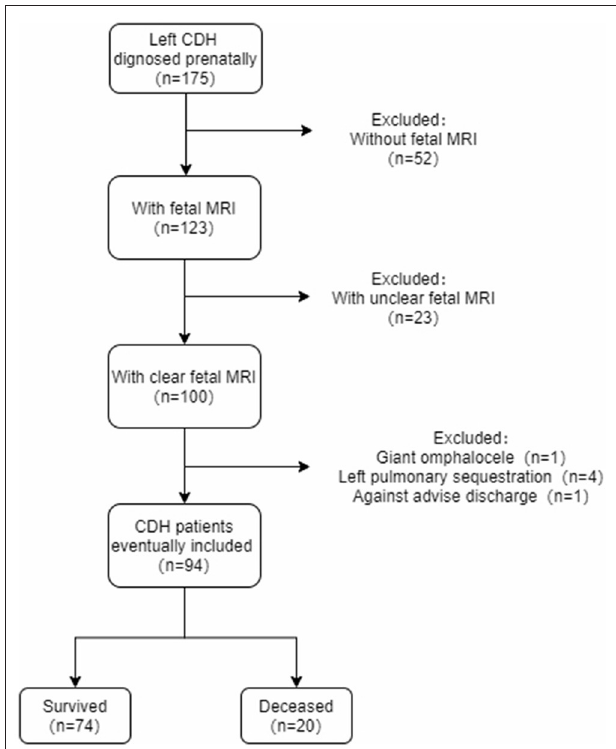
FIGURE 2 | The inclusion flow